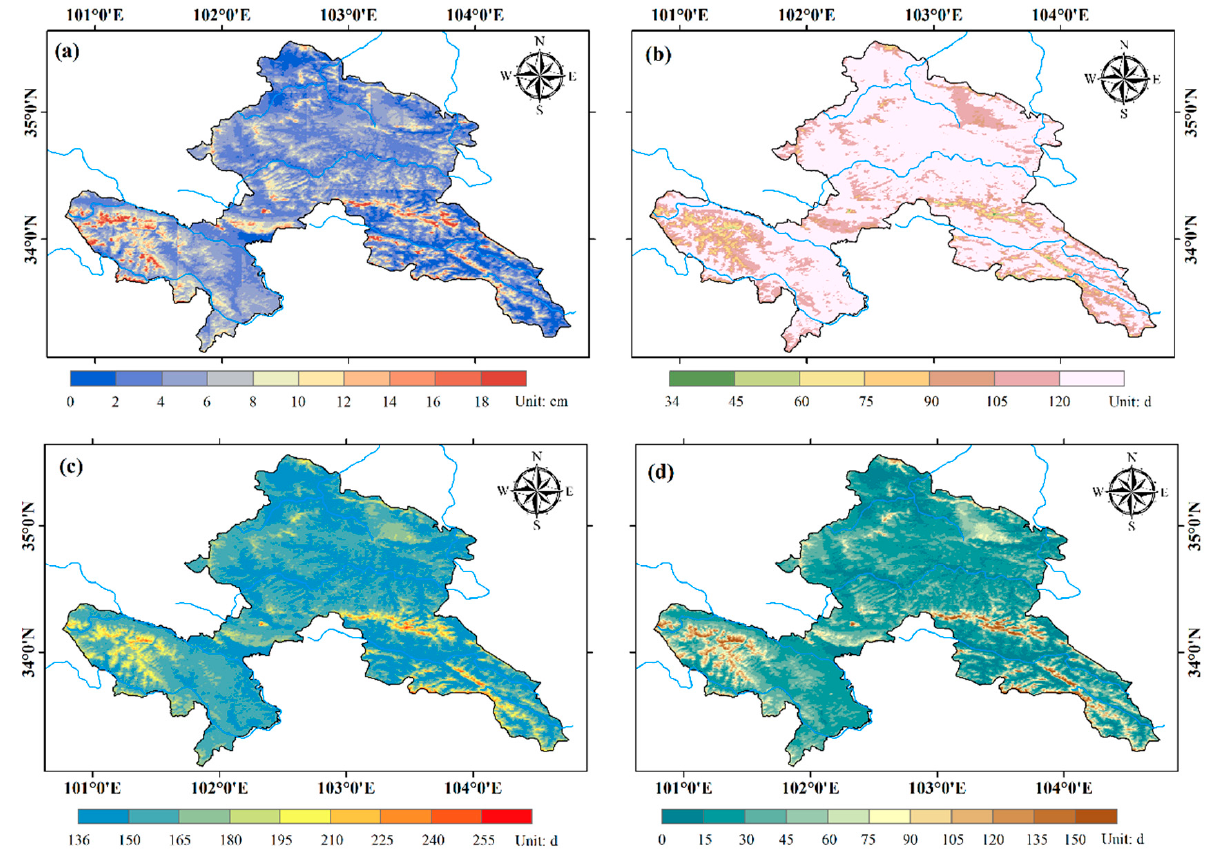
Figure 4. The spatial distribution of LSSPs on the SGP. Subplots ( a – d ) are for SD, SCS, SCM, and SCD.